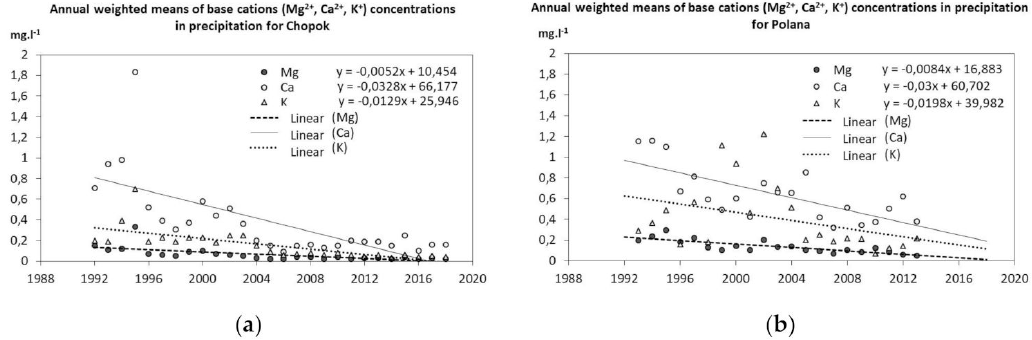
Figure 6. Annual mean weighted concentrations of base cations (Mg 2 + , Ca 2 + , K + ) in precipitation: ( a ) Chopok, ( b )